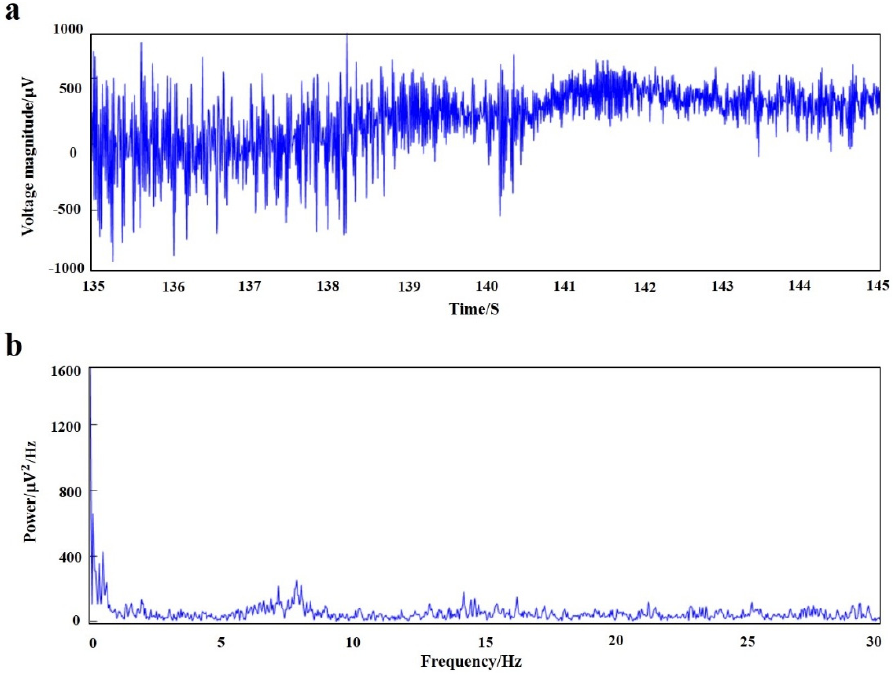
Figure 11. Acute electroencephalogram of anesthetized rats. ( a ) Local field potential time-domain waveform; ( b ) power spectral density